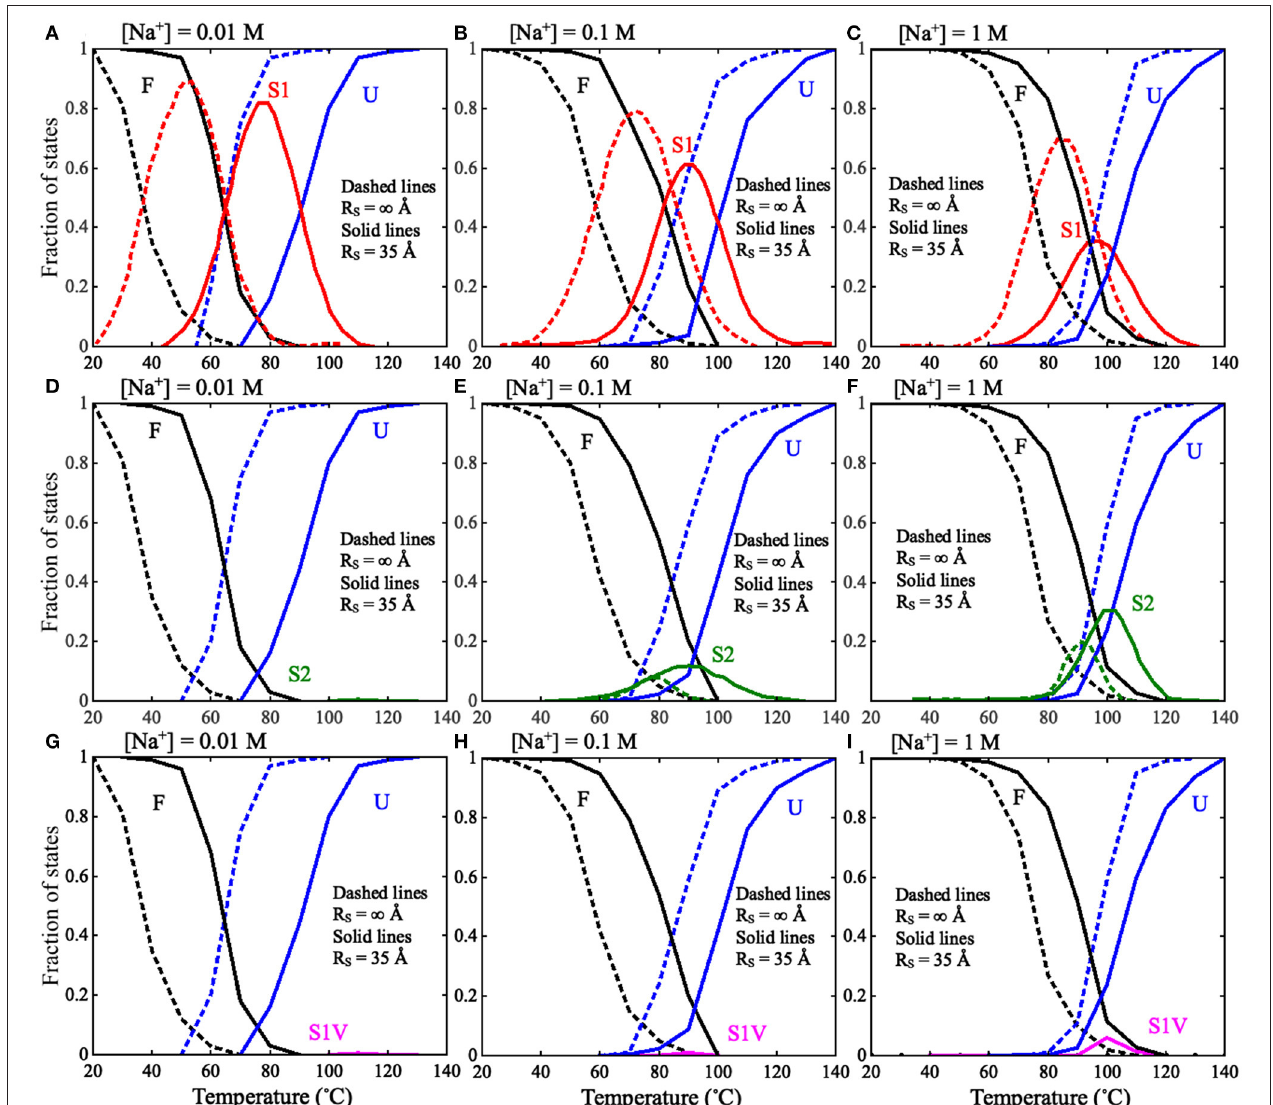
FIGURE 6 | The fractions of F, S1, S2, S1V, and U states as functions of temperature in thermal unfolding of the mouse mammary tumor virus (MMTV) pseudoknot for R S = ∞ Å (dashed lines) and R S = 35 Å (solid lines): (A–C) The fractions of F, S1, and U states at (A) 0.01M [Na + ], (B) 0.1M [Na + ], and (C) 1M [Na + ]. (D–F) The fractions of F, S2, and U states at (D) 0.01M [Na + ], (E) 0.1M [Na + ], and (F) 1M [Na + ]. (G–I) The fractions of F, S1V, and U states at (A) 0.01M [Na + ], (B) 0.1M [Na + ], and (C) 1M [Na + ]. F stands for fully folded RNA, S1 stands for hairpin intermediate with Stem 1, S2 stands for hairpin intermediate with Stem 2, S1V stands for Stem1 variation, and U stands for fully unfolded